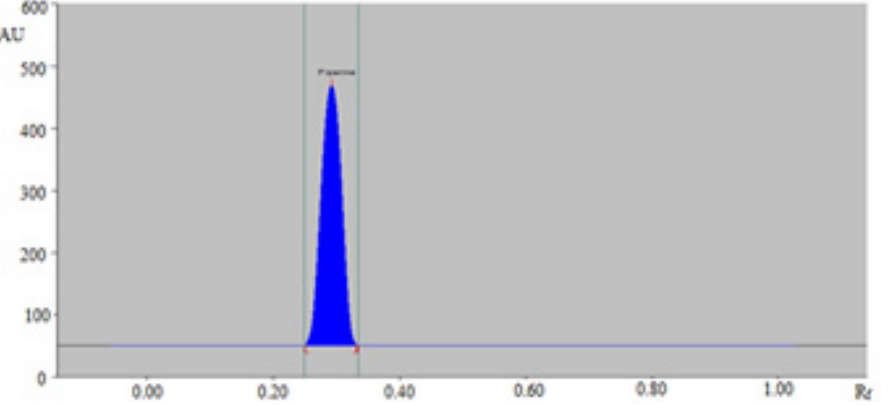
Figure 4. Densitometry chromatogram of PPN in methanolic extract of black pepper (BPMH) recorded using normal-phase HPTLC technique.